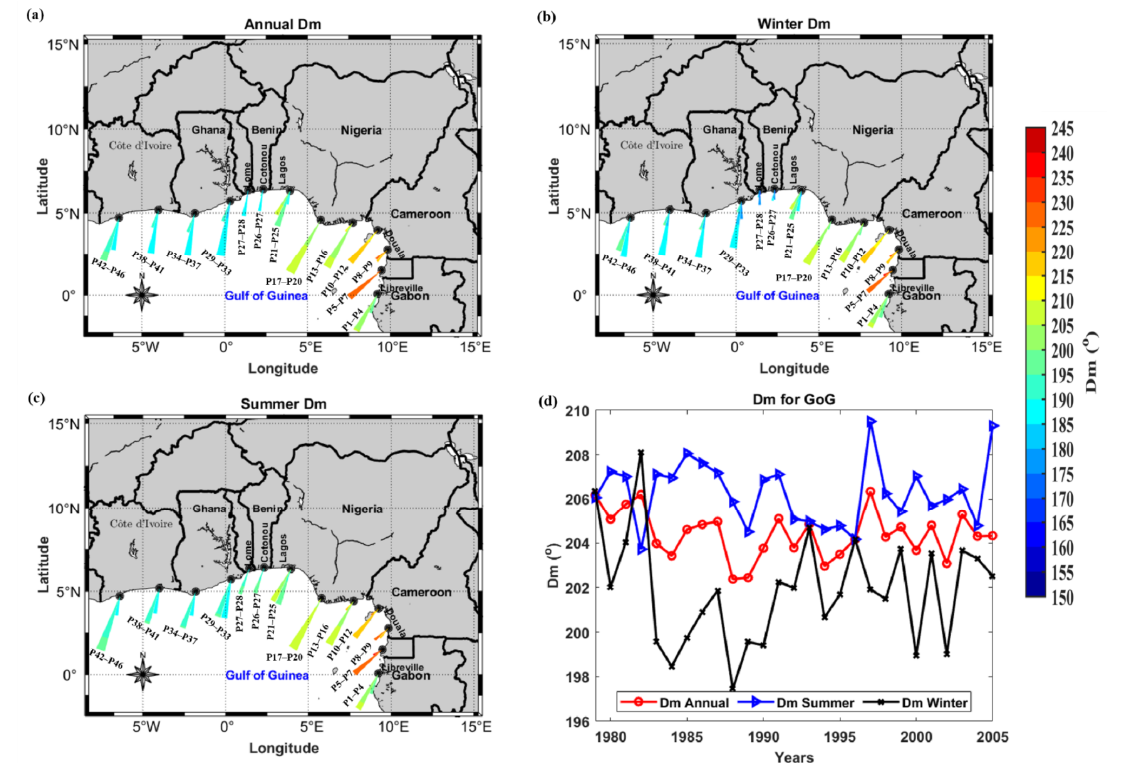
Figure 6. Wave roses showing direction-oriented spatial distribution of average ( a ) extreme annual Dm ( b ) extreme winter Dm ( c ) extreme summer Dm ( d ) timeseries of Dm between 1979 – 2005. Table 4. Average extreme Dm and its trends between 1979 – 2005.